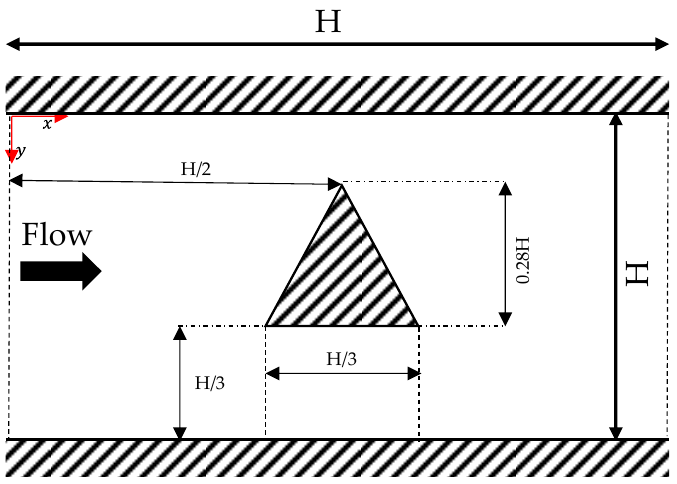
Figure 9. Benchmark domain adapted from [42].